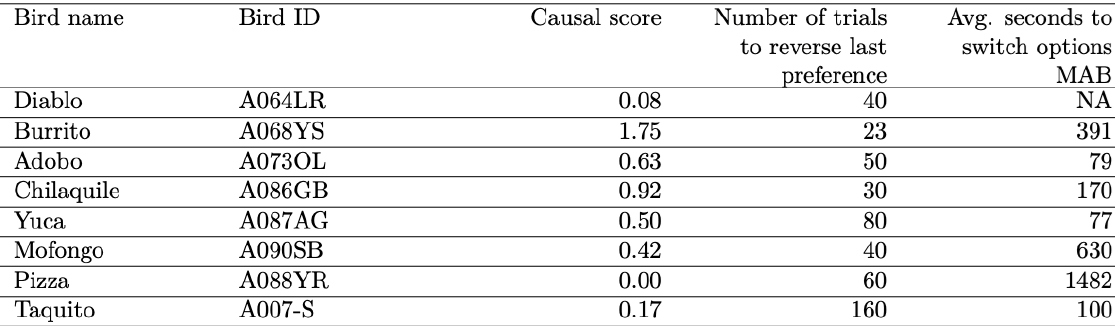
Table 1. Grackle causal cognition scores. The two flexibility measures (data from Logan, MacPherson, et al. 2019) are: the number of trials to reverse a preference in that bird’s most recent reversal, and the average number of seconds to switch to attempting a new option after having successfully solved a different option on the multi-access log (MAB). We used only data from the MAB log experiment and not the MAB plastic box experiment because the log and plastic scores did not correlate with each other (Logan, MacPherson, et al. 2019) and there was data for more birds for the log experiment that were in the causal cognition study. Note: Mole did not complete the causal cognition experiment because he had to be finished.